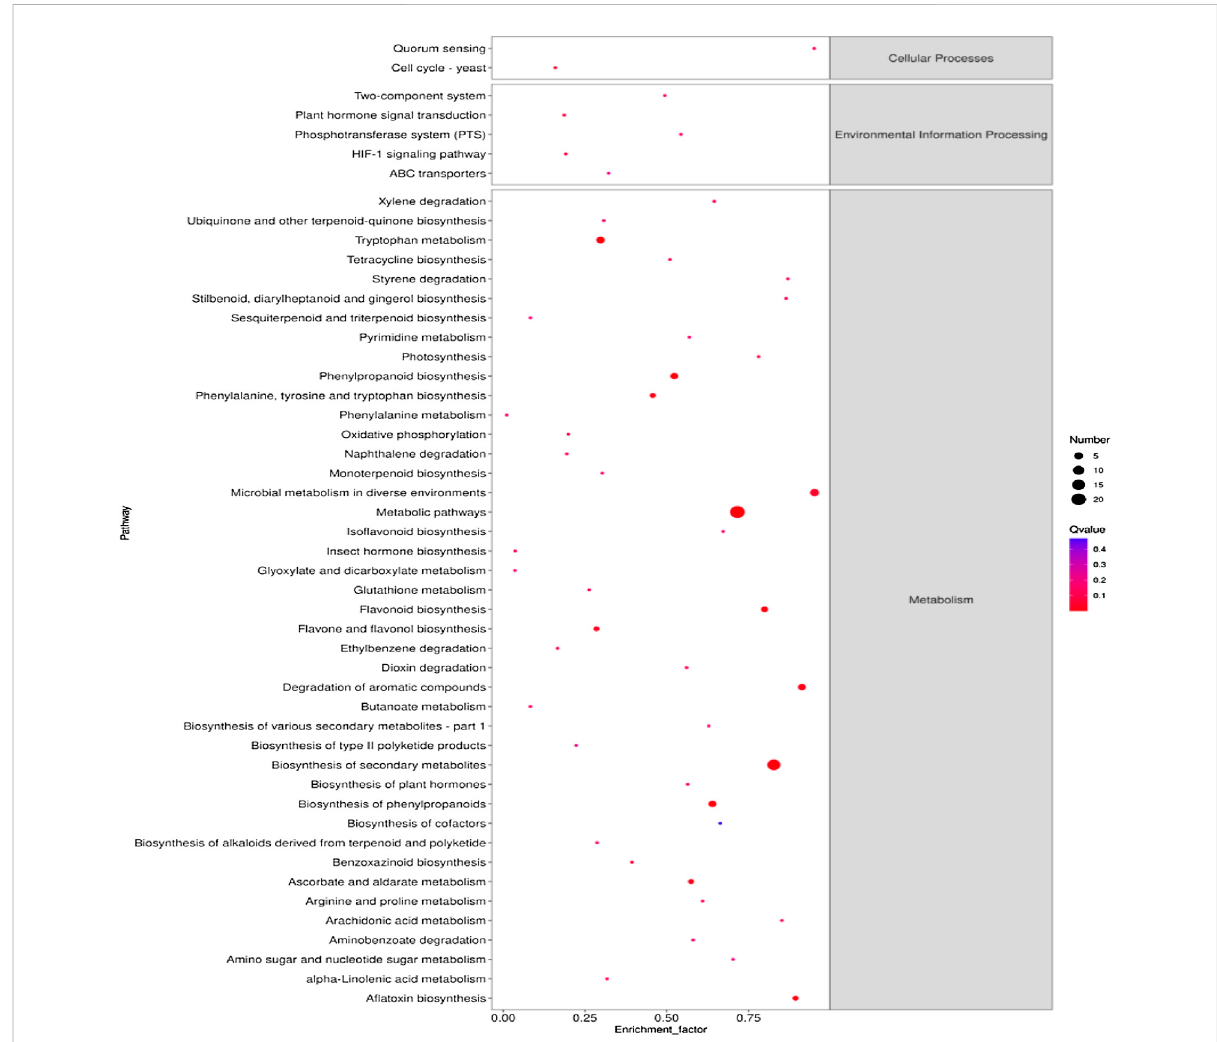
FIGURE 3 KEGGmetabolicpathwayenrichmentanalysisofthedifferentialmetabolitesindifferentAR-Cdtreatmentgroups.Themostsigni fi cantcatalogs with lowest corrected p values are